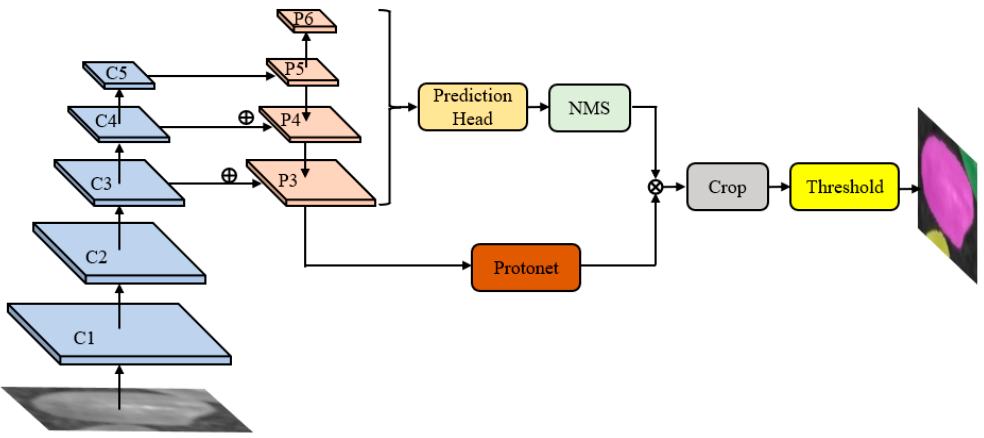
Figure 8. The YOLACT network structure after removing the P7 layer from the FPN structure. Table 3. Performance of YOLACT network with different parameters on the polished rice